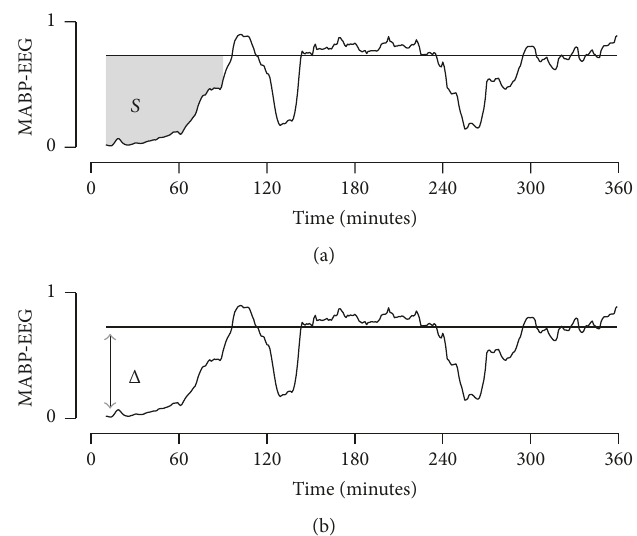
Figure 5: Features used to quantify the reduction in signal interaction strength: S (gray shaded area) (a) and Δ (gray arrow) (b). The feature values are illustrated for one neonate in the group of study (PMA 30 weeks, 2.5 mg · kg − 1 ), where the pairwise interaction was computed using k x x S and Δ are computed from 0 to 90 minutes, while the reference level is de fi ned as the median value of the T i , j (2). Feature values interaction curve from 180 to 360